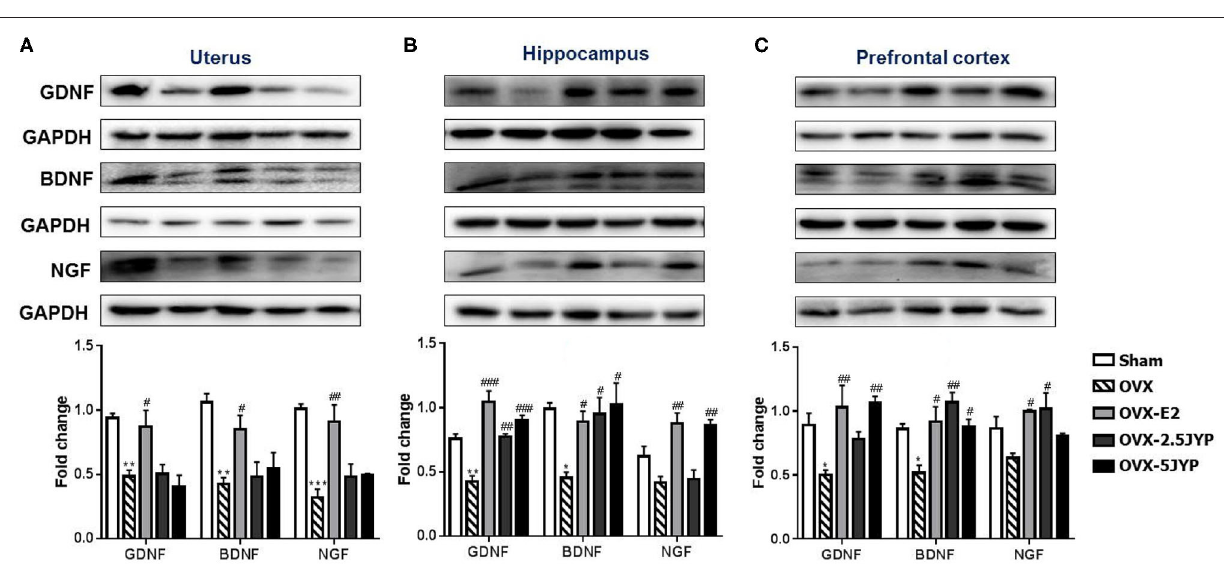
hypothalamic GABA contents. However, unlike E2, JYP did not affect blood estradiol level. JYP appears to mainly modulate axis hyperactivity by reinstating the